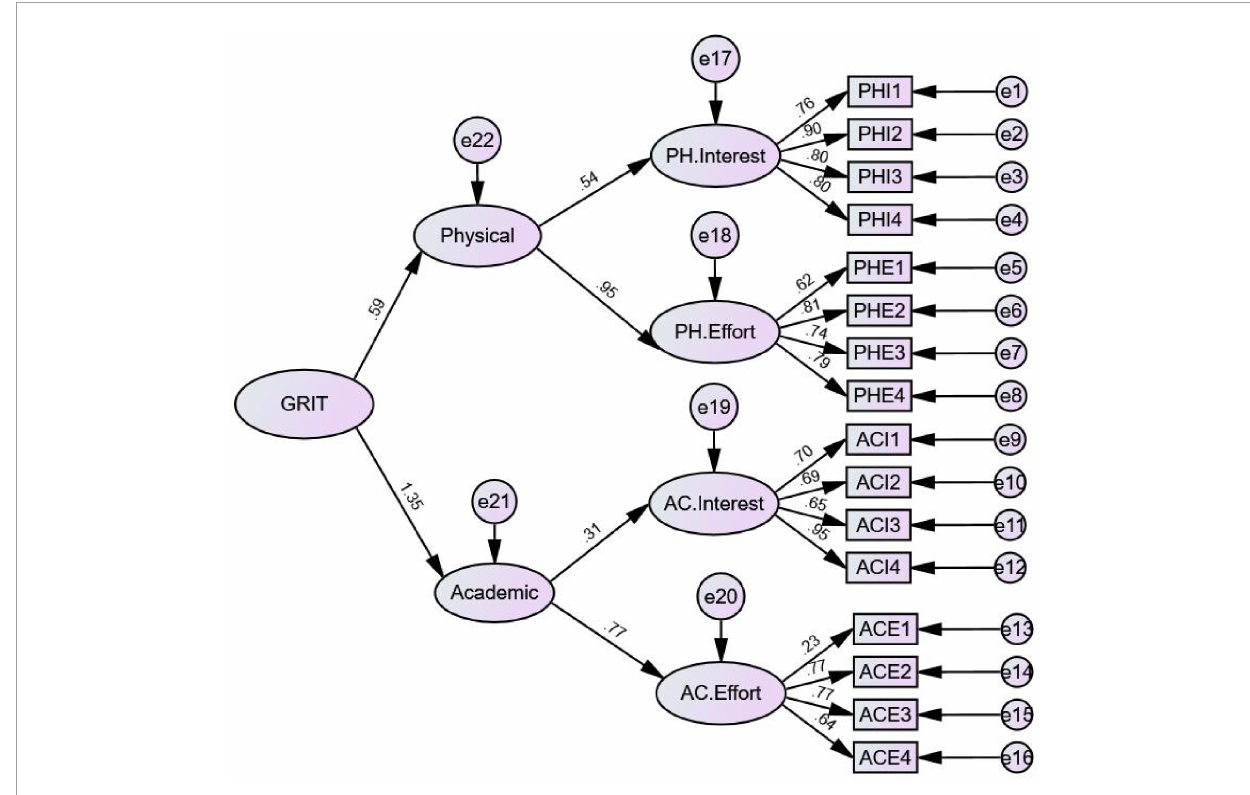
FIGURE1 The third-order factor model of the PE-Grit . All parameters are standardized and significant at the 0.01 level.